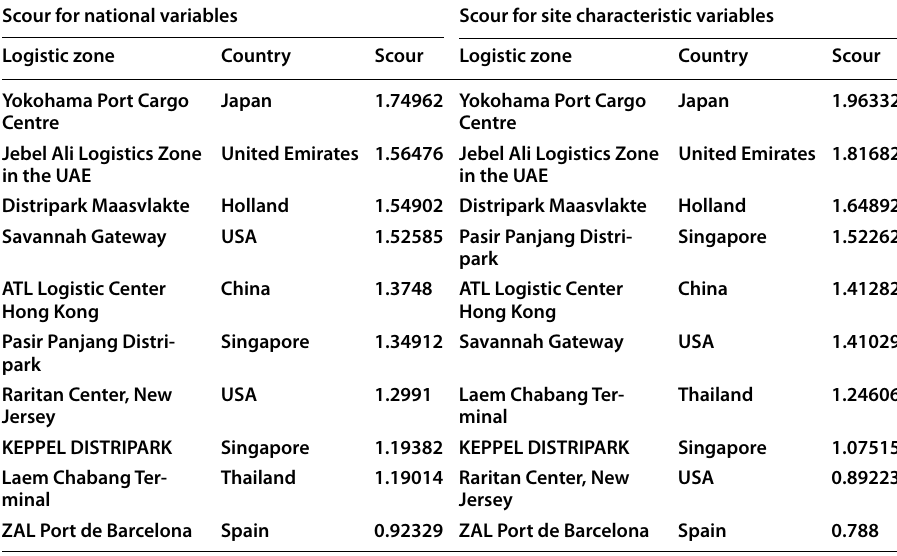
Table 9 The highest countries according to factor scour value Scour for national variables